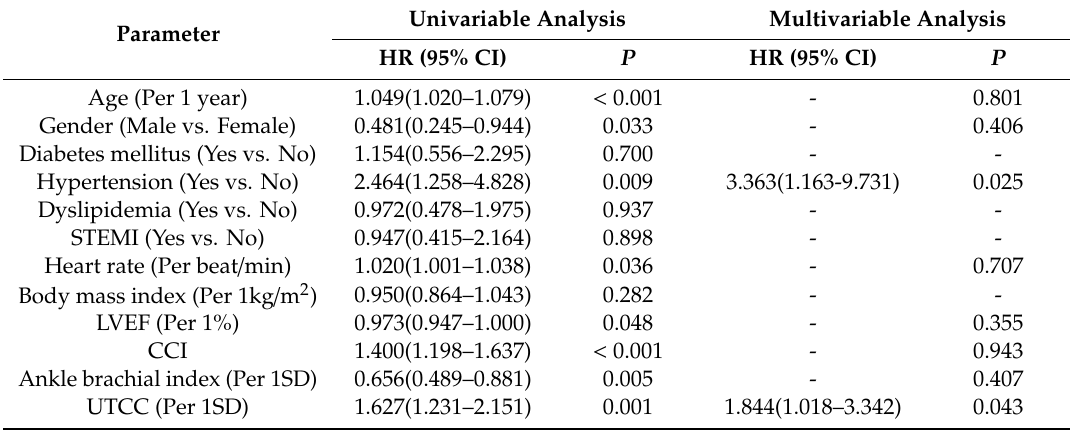
Table 2. Predictors of cardiovascular mortality using the Cox proportional hazards model by univariable and multivariable analysis. Parameter